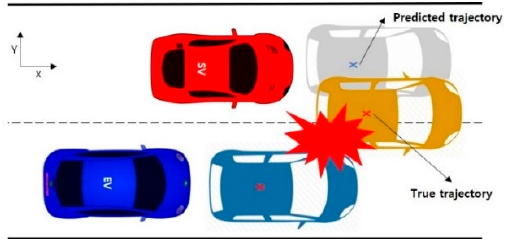
Figure 1. Collision situation caused by lateral position error.